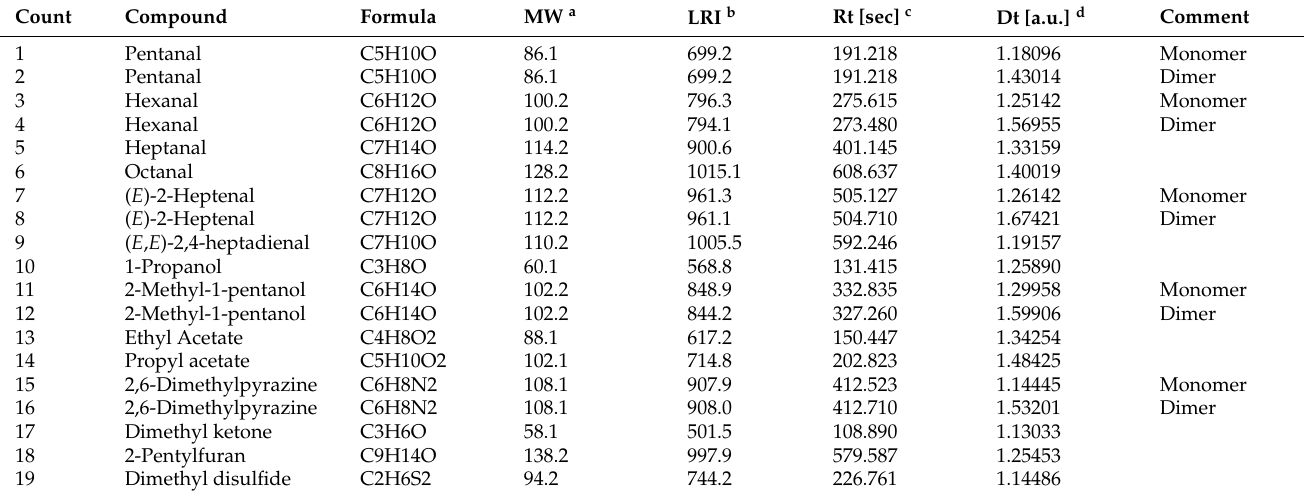
Table 1. The volatile compounds identified by headspace-gas chromatography-ion mobility